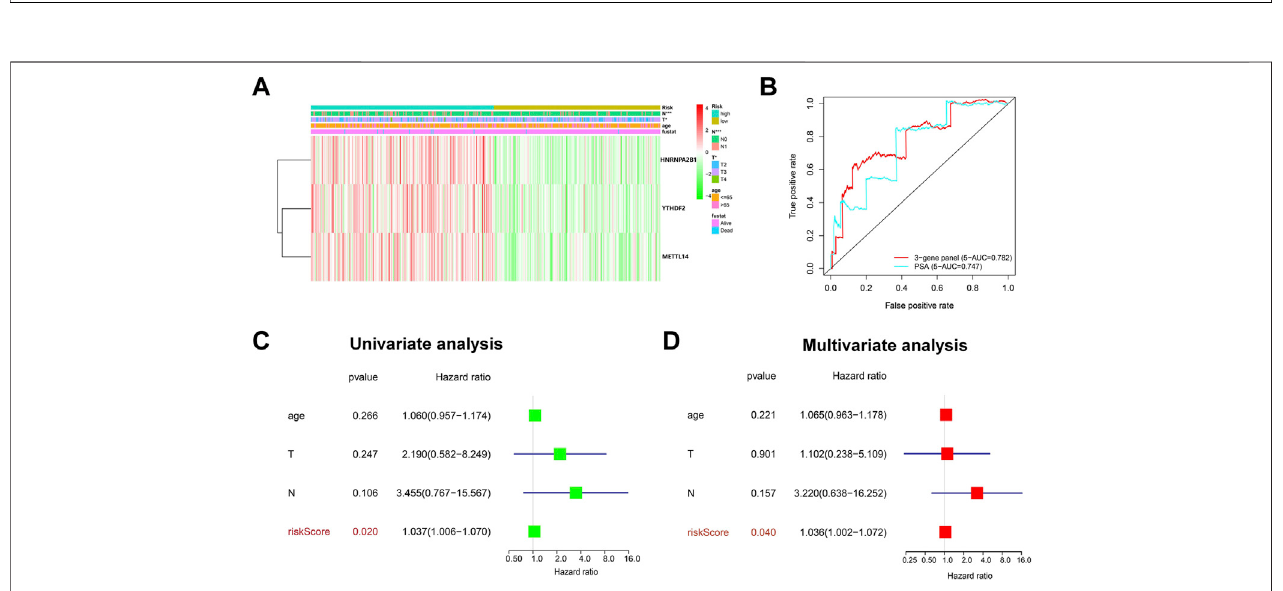
FIGURE4| Evaluationofthepredictionperformanceofthem 6 Aprognosticscoringmodel. (A) Heatmapshowingthedifferencesintheclinicopathologicfeaturesof PCa patients with low-risk group and high-risk groups. (B) The predictive ef fi ciency of the 3-gene panel and PSA were shown by a 5-year ROC curve. (C,D) Univariate and multivariate analysis of the correlation between clinicopathological features and overall survival of PCa patients.